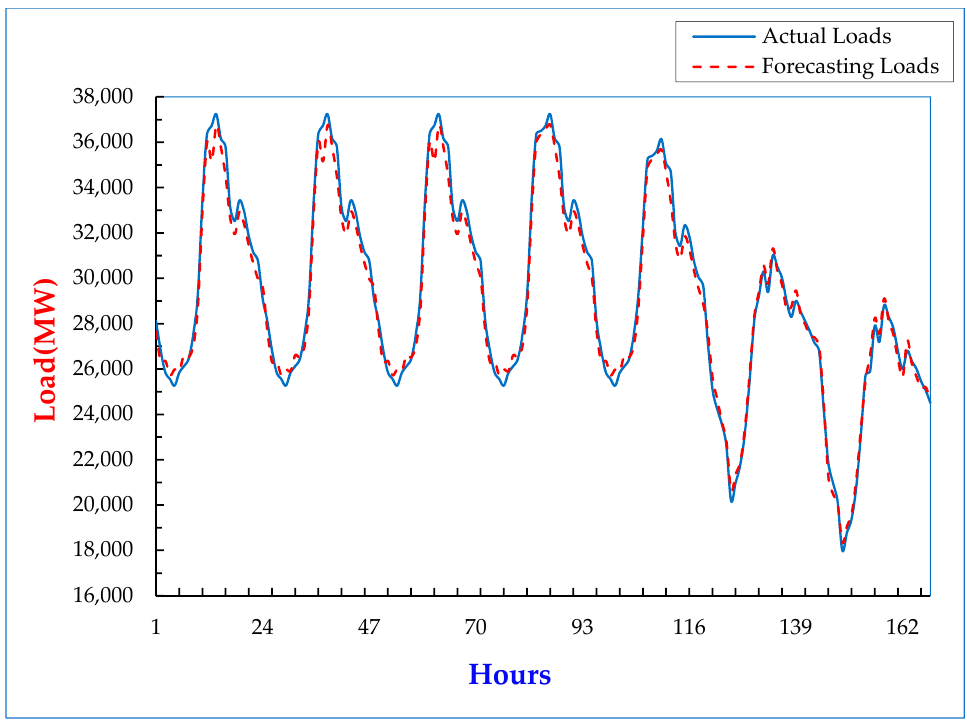
Figure 7. Load forecasting for the typical 2020 spring week (Monday 11 May 2020 to Sunday 17 May 2020).